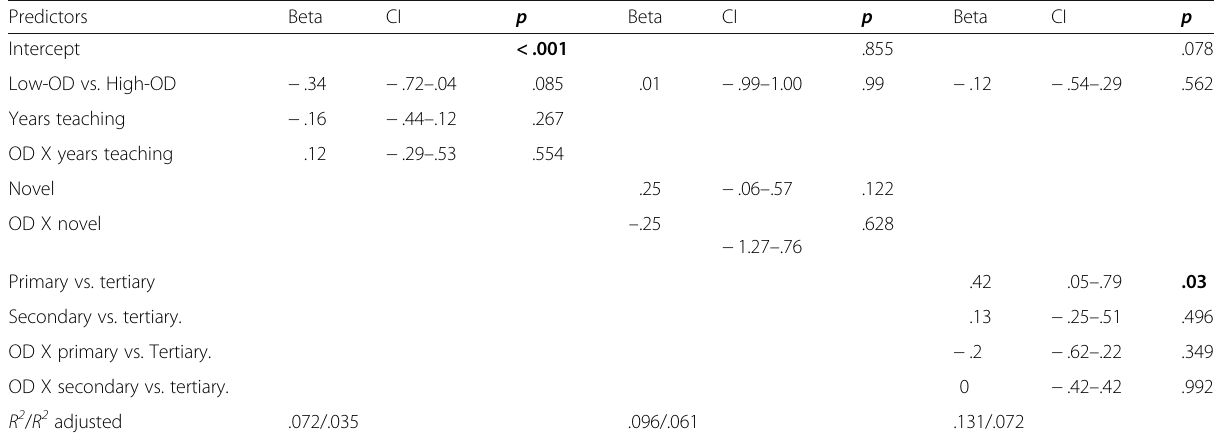
Table 2 Results of the exploratory regressions performed using teacher background variables from Experiment 6 with efficacy rating as the criterion